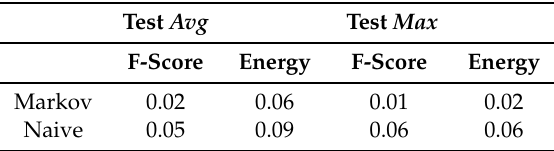
Table 5. The average prediction error when predicting the energy requirements and F-score of assignments in the non-dominated set, for both tests, made by the naive and Markov chain